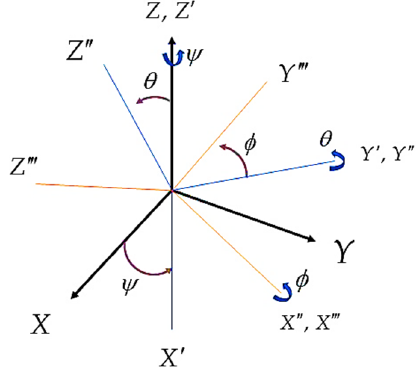
Figure 2. Rotation between frames using Euler Angles.